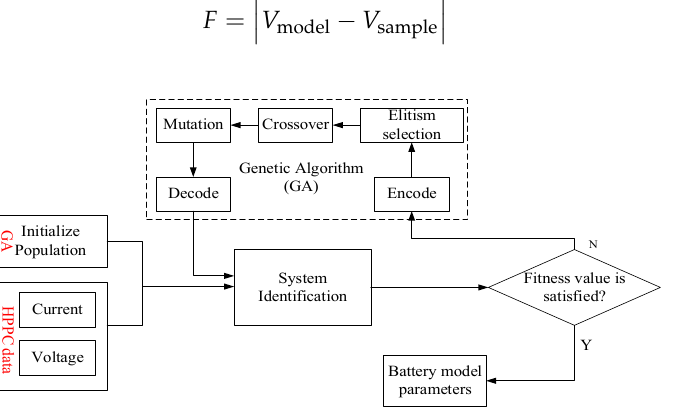
Figure 2. Parameter identification based on genetic algorithm (GA).